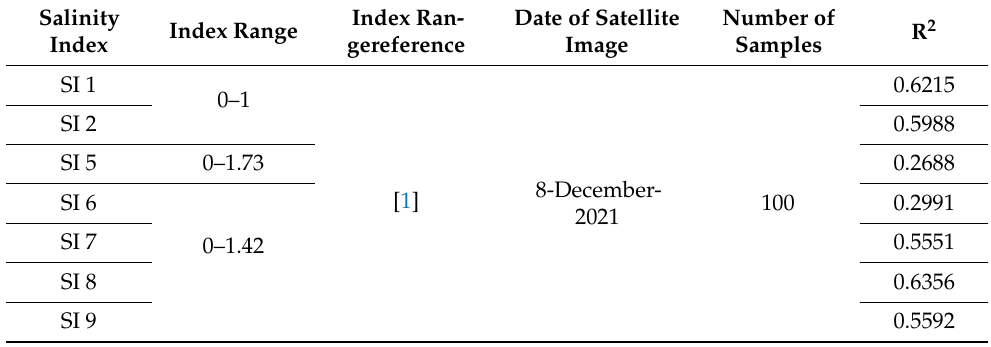
Table 4. Linear regression results for seven different salinity indices of year 2021.